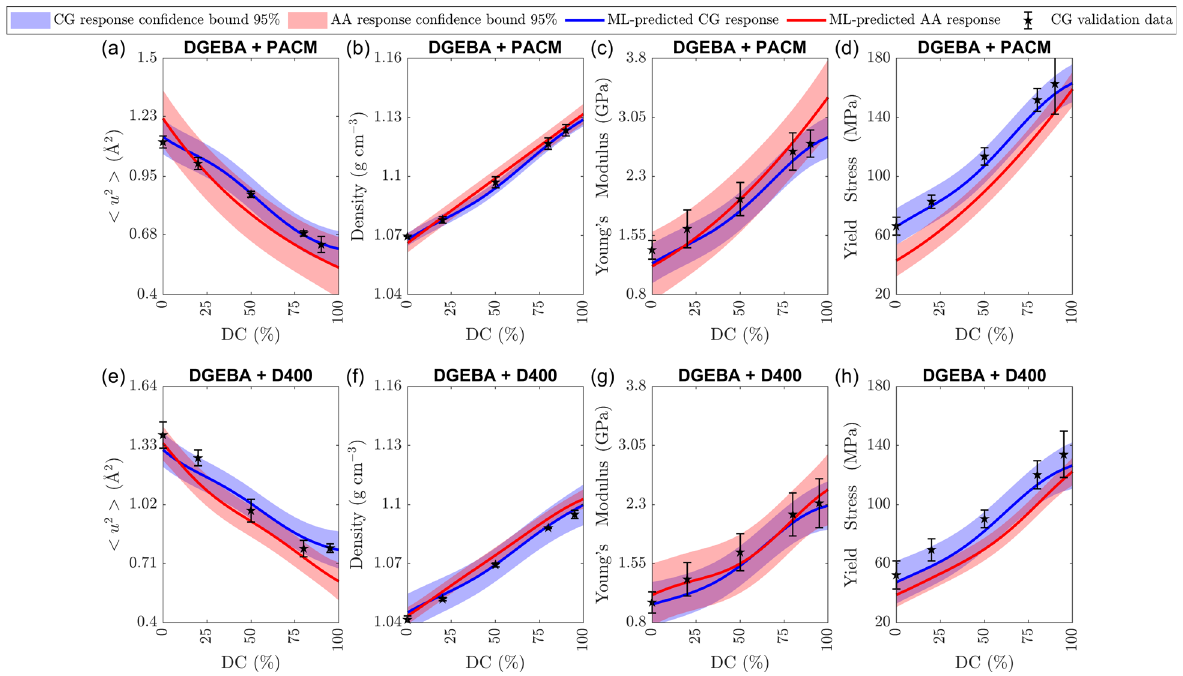
Fig. 5 Validation of the predictive power of the Gaussian process interpolation. Comparison of the target properties as a function of DC between the Gaussian process AA model (red lines), the CG model (blue lines) with the simpli fi ed parametrization shown in Fig. 4, and the results of the corresponding CG simulations (black stars). Debye-Waller factor, density, Young ’ s modulus and yield stress are reported for the DGEBA + PACM system ( a – d ) and for the DGEBA + D400 system ( e – h ). The con fi dence intervals were obtained from the data of Fig. 2 for the AA simulations and the design of experiments simulations for the CG model. The error bars on the black stars result from the variance of statistically independent CG simulations. The parametrization of Fig. 4 gives a fair agreement 59 for all our targets from the uncrosslinked systems to the fully crosslinked epoxy networks (average RMSPE = 10%). The CG simulation data are in line with the ML-CG prediction, and close to the AA prediction. Slightly higher accuracy is possible with different parametrizations, but at the cost of greatly increasing the complexity of the force fi eld. We discussed other formulations in our Supplementary